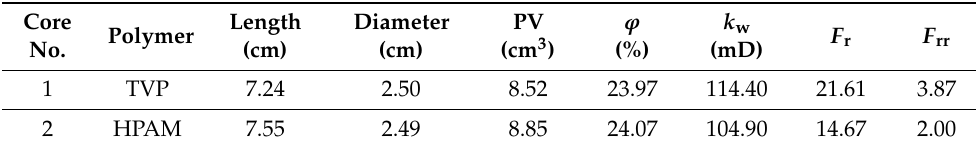
Table 1. The resistance factor ( F r ) and residual resistance factor ( F rr ) of 0.1% TVP and HPAM solutions flowing in natural Daqing cores at 45 ° C.